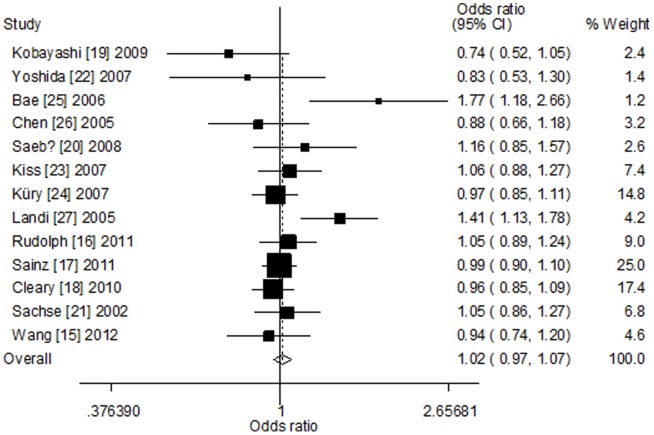
Forest plot of CYP1A2*F polymorphism and colorectal cancer risk among overall analysis (additive model).